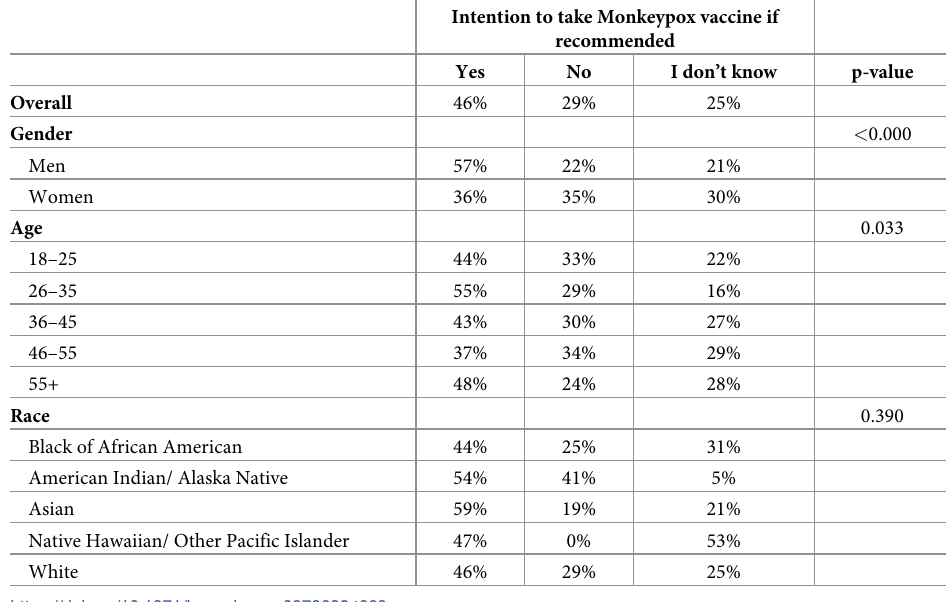
Table 3. Monkeypox vaccination intentions by demographics (n = 856).